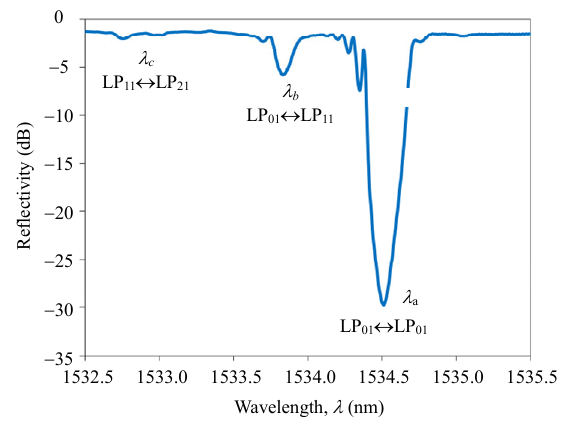
Fig. 2 Transmission spectrum of the 2SF grating reflectivity before thermal annealing process at room temperature (25 ℃ ).